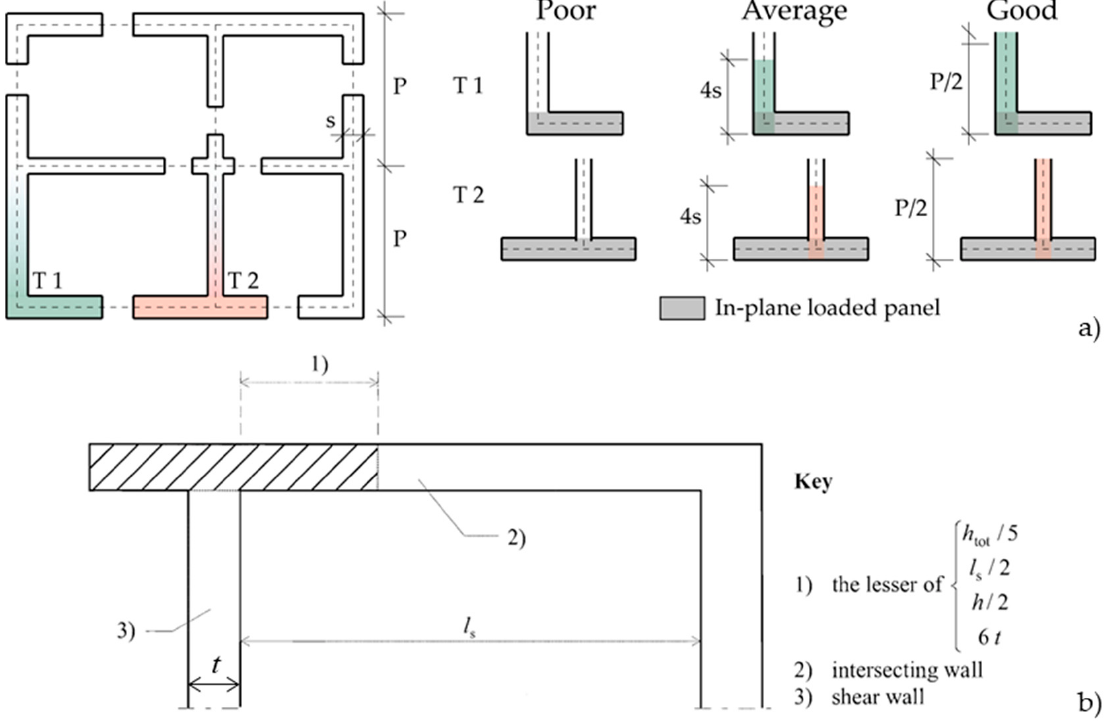
Figure 1. Criteria for defining the effective width for the flange as proposed in the following: ( a ) [27], the corner case—L-section shape—is marked in green while the internal intersection—T-section shape—is marked in pink; and ( b ) Eurocode 6, Part 1-1 [28] (adapted from the corresponding references).